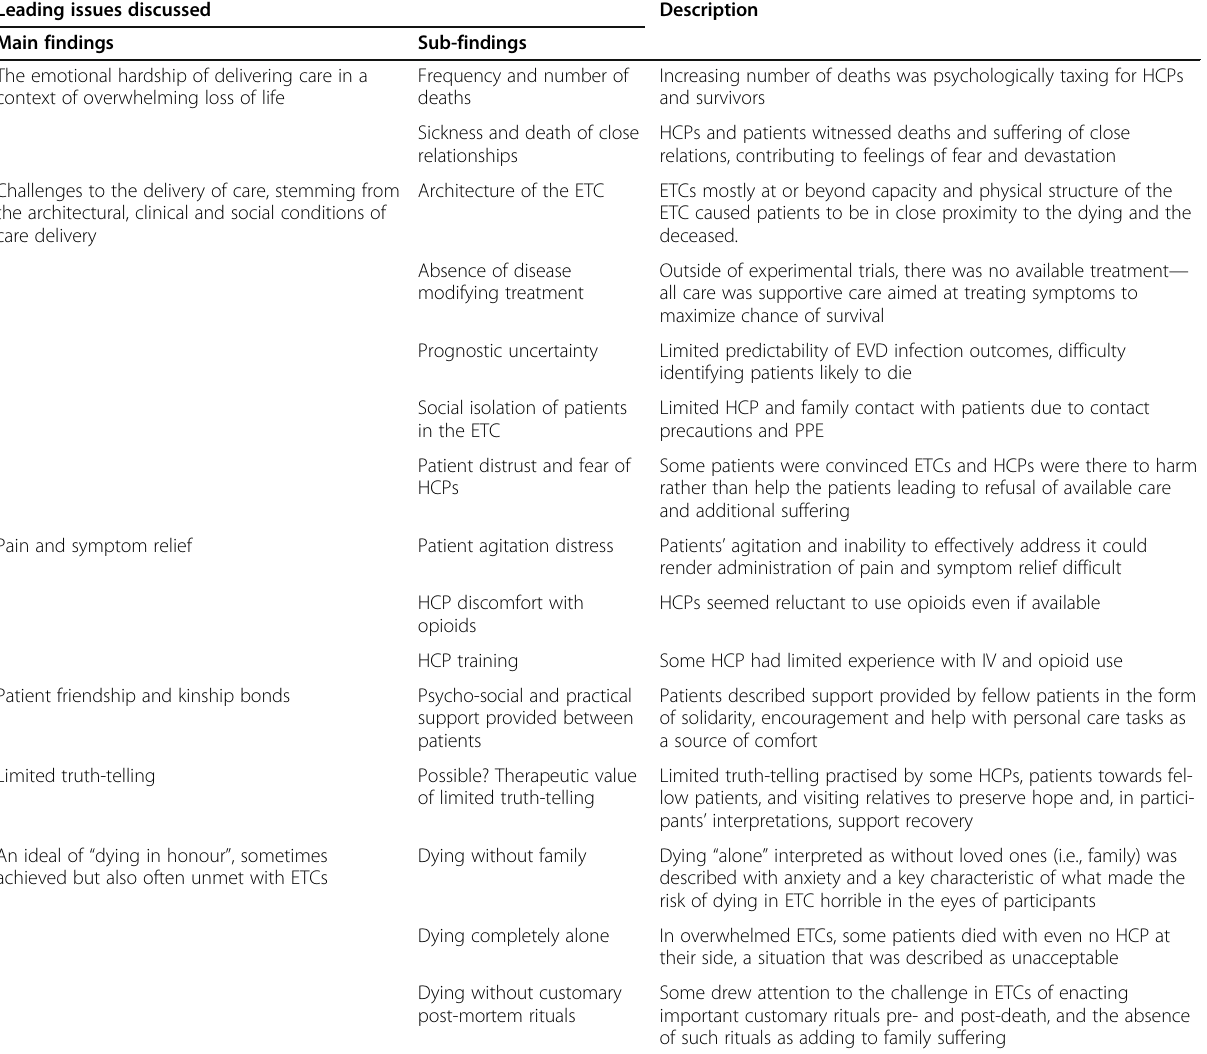
Table 2 Key issues discussed related to end-of-life palliative care for patients infected with EVD in Guinea Leading issues